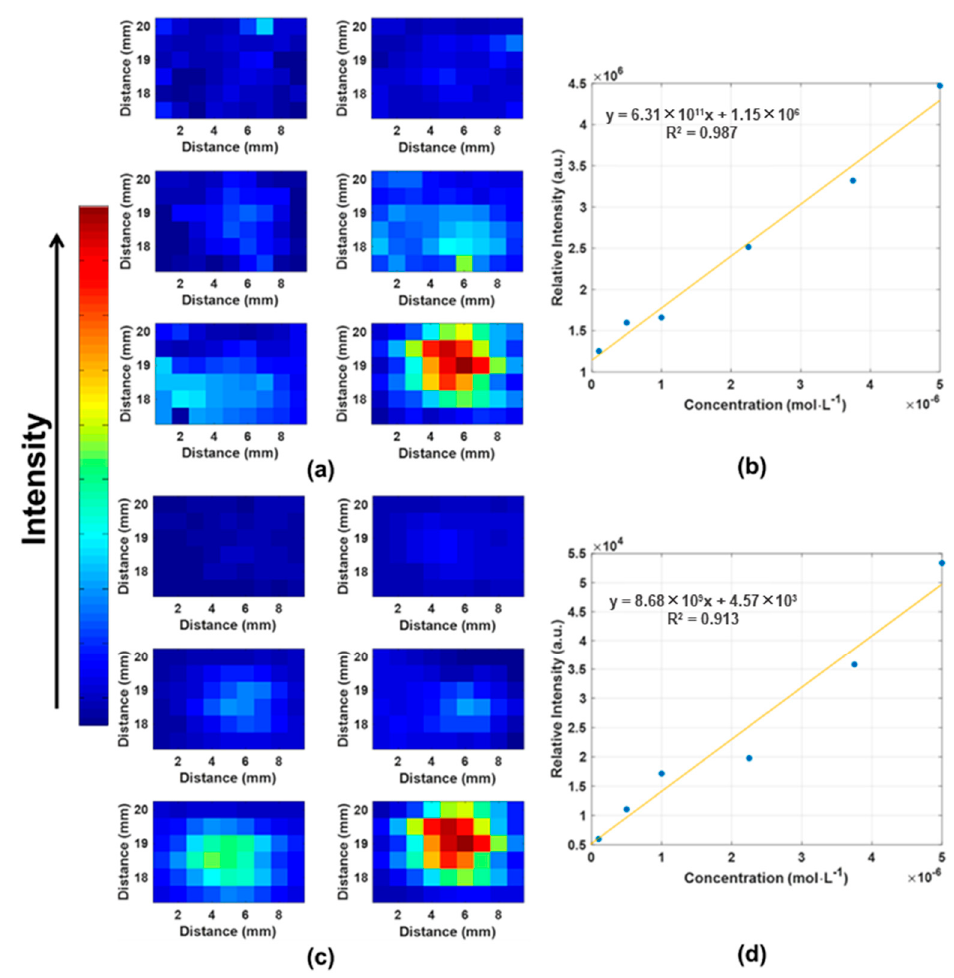
Figure 9. ( a ) TMP score maps recovered by MCR-ALS and ( b ) analytical curve. ( c ) Score maps recovered by ICA and ( d ) analytical curve.